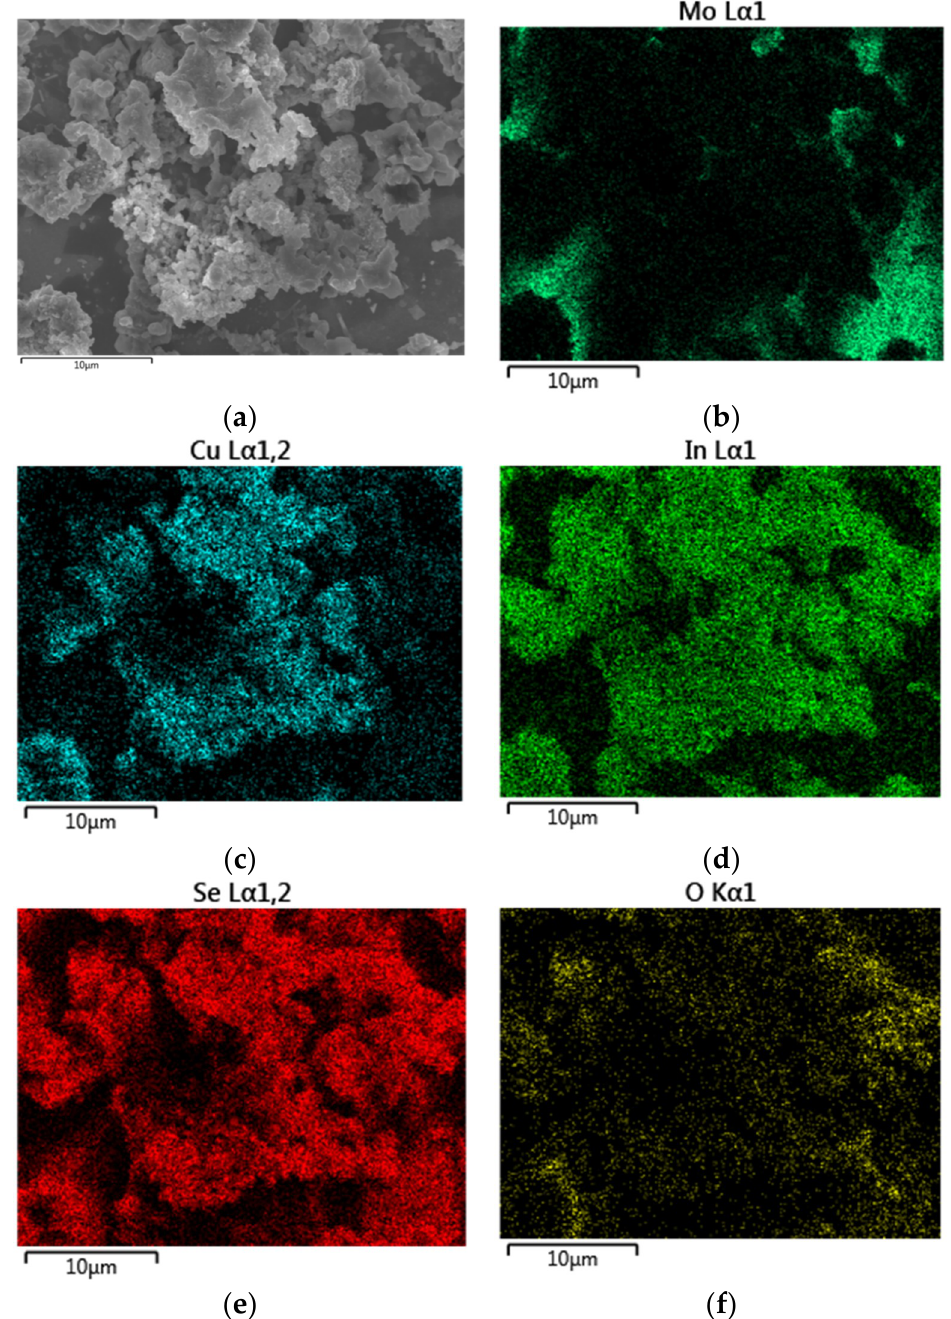
Figure A5. EDX mapping ( a ) of IPA based route II CISe film with an elemental composition of Cu: 15.5 at % ( c ); In: 17.6 at % ( d ); Se: 32.1 at % ( e ); O: 7.7 at % ( f ). Mo of back contact ( b ) is visible where the CISe film does not cover the back electrode.